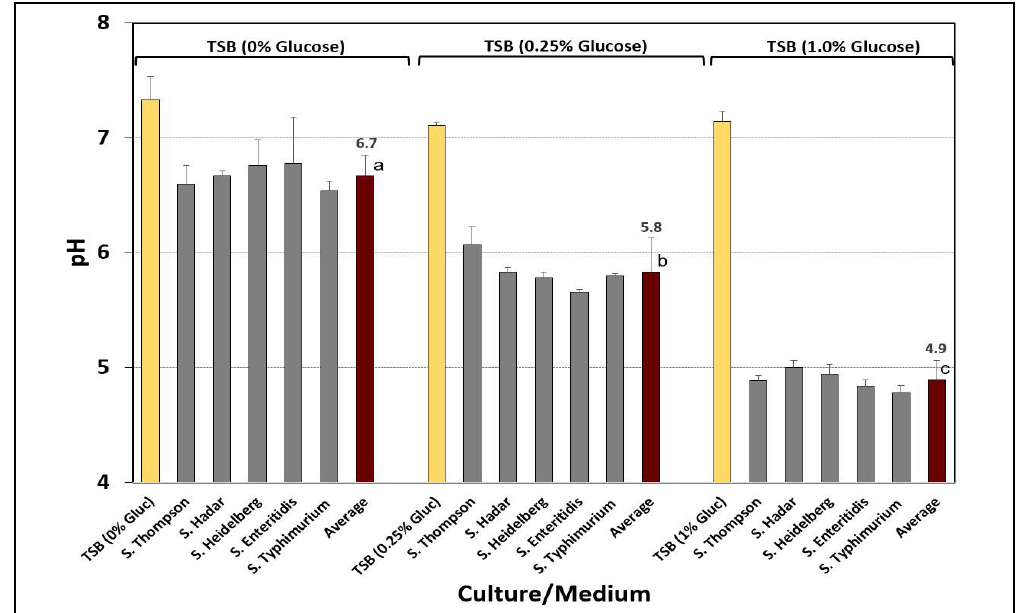
Figure 2. Analysis of spent broth pH for Salmonella cultures grown in Tryptic Soy Broth (TSB) containing 0%, 0.25%, or 1% glucose incubated at 37 °C for 18 hrs. The data bars in each set are pH values for the medium before inoculation, the five individual cultures after growth, and the average pH of the five cultures. Cultures include S. Thompson 120, S. Heidelberg F5038BG1, S. Hadar MF60404, S. Enteritidis H3527, and S. Typhimurium H3380. Data are presented as the mean of triplicate replications and error bars represent the standard deviation from the mean. Means (for average pH) with different letters are significantly different, as determined by one-way ANOVA using the Holm–Sidak test for pairwise multiple comparisons to determine significant differences ( p < 0.05); means with different letters are significantly different ( p < 0.05).